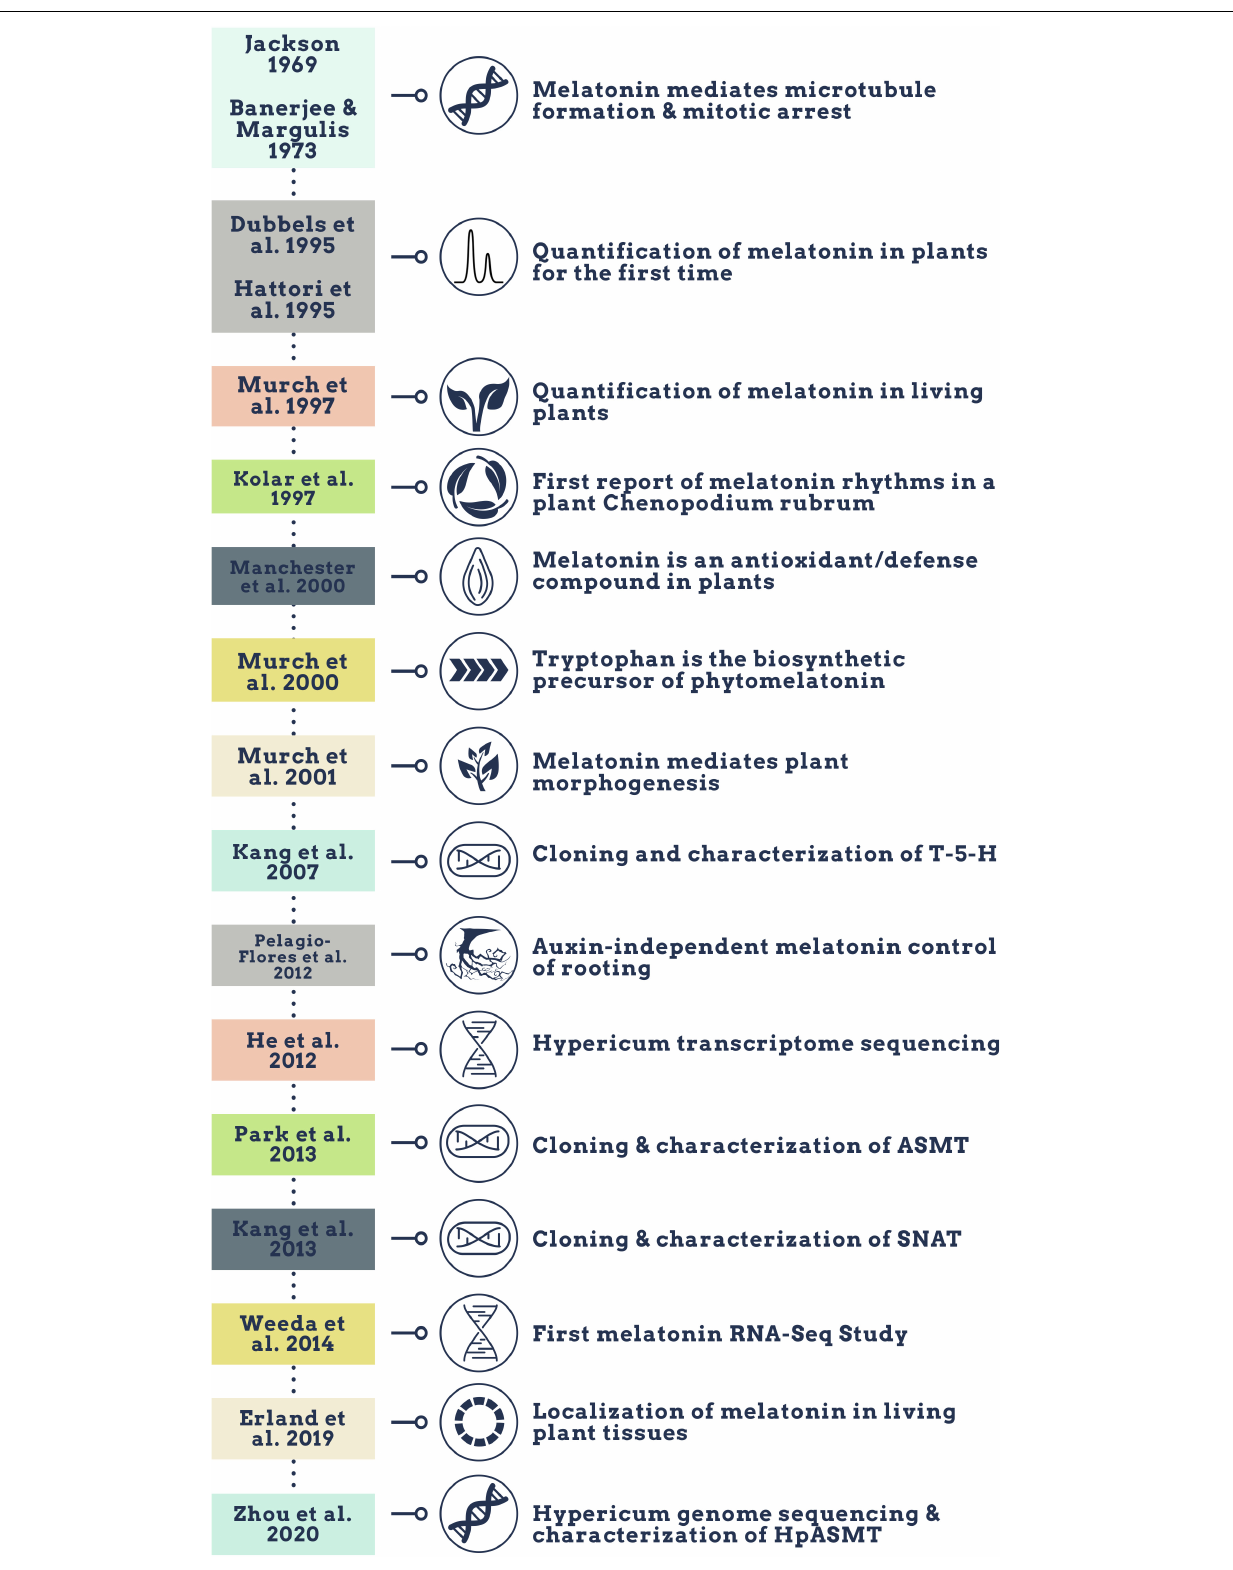
Frontiers in Plant Science |